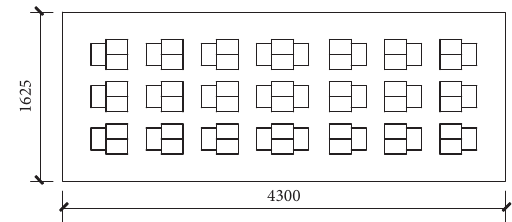
Figure 5: Layout of the iron blocks.